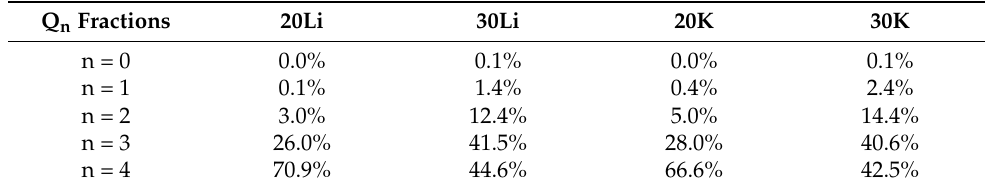
Table 6. The fractions of Si Q n groups in the simulated alkali aluminosilicate